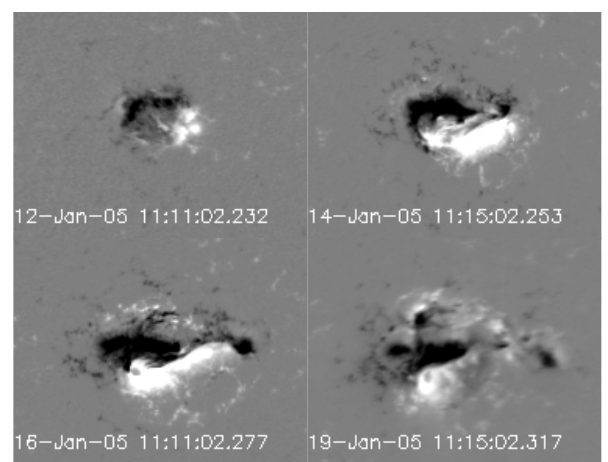
Fig. 11. MDI images showing the evolution of the magnetic con- figuration of AR 10720. The images have been derotated to central meridian passages (CMP). The FOV is 319 × 207 pixels (each pixel is 1.98arcsec size) and the field is saturated below (above) − 800G